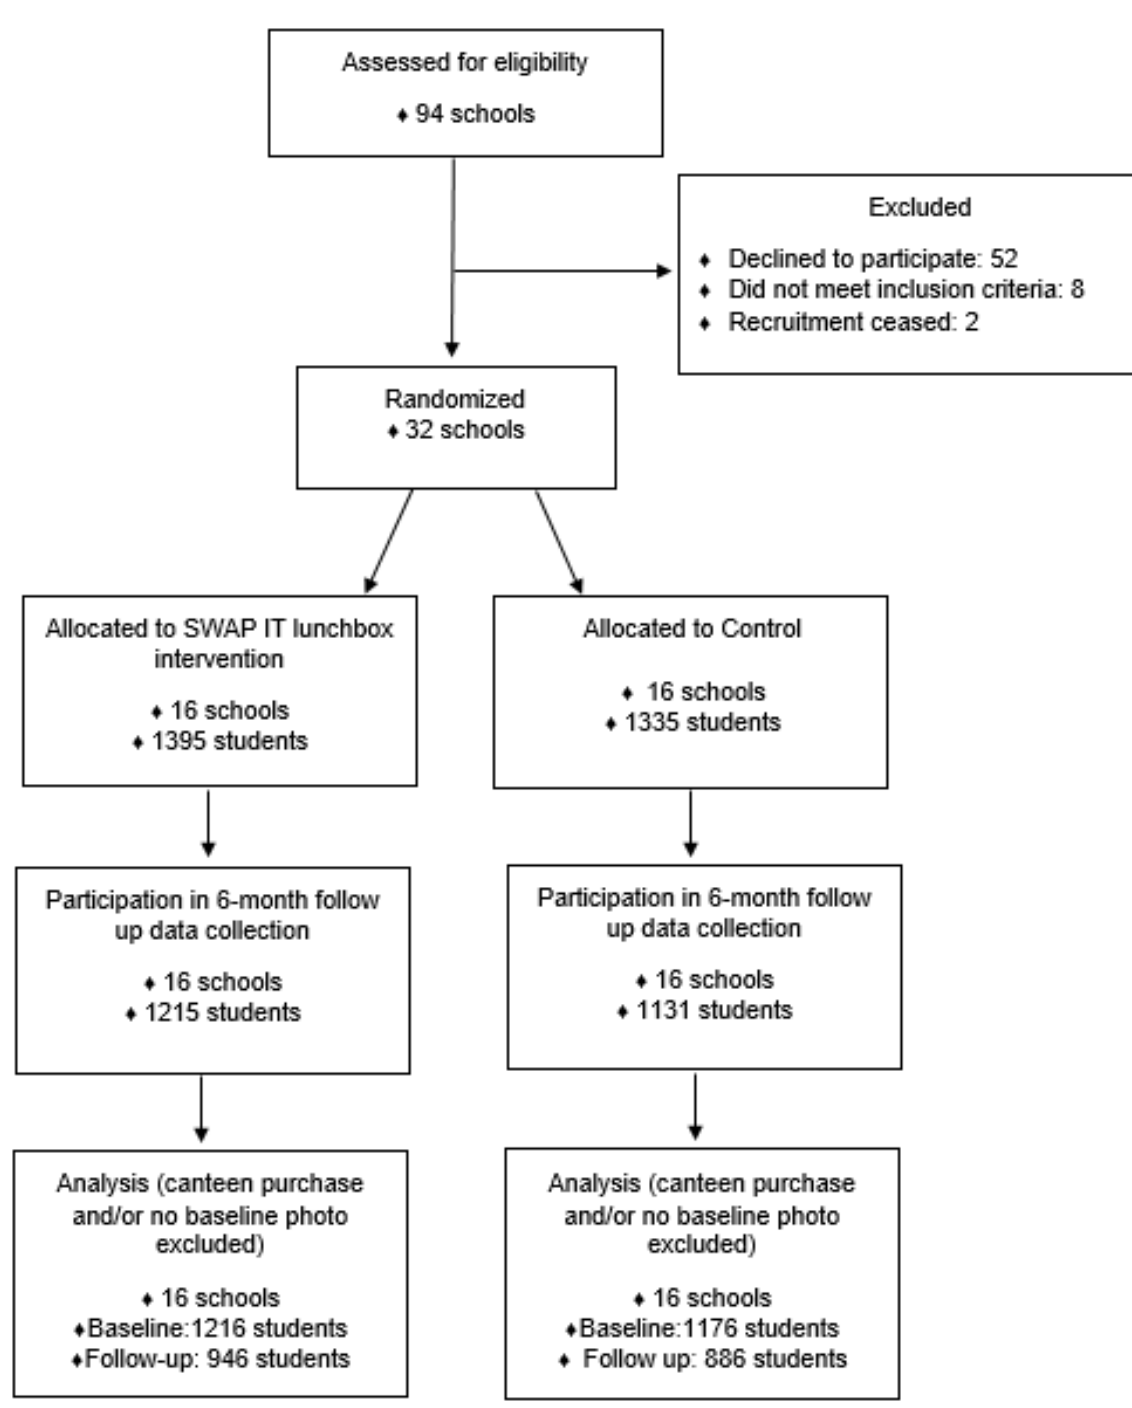
Figure 1. Consolidated Standards of Reporting Trials (CONSORT) flow